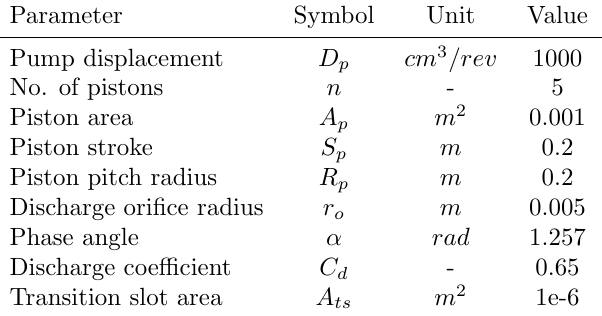
Table 4: Axial piston pump parameters